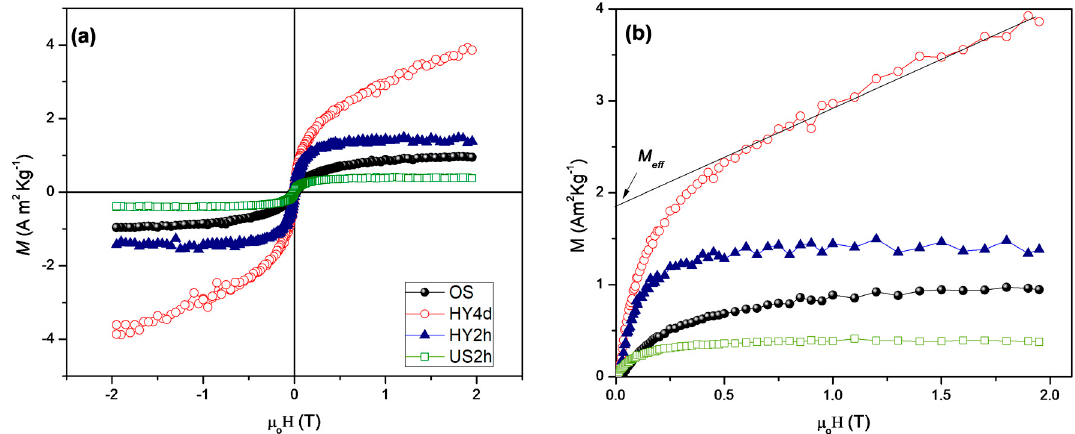
Figure 3. SEM images of EMT-type zeolite formed by 4-days conventional hydrothermal process (HY4d).